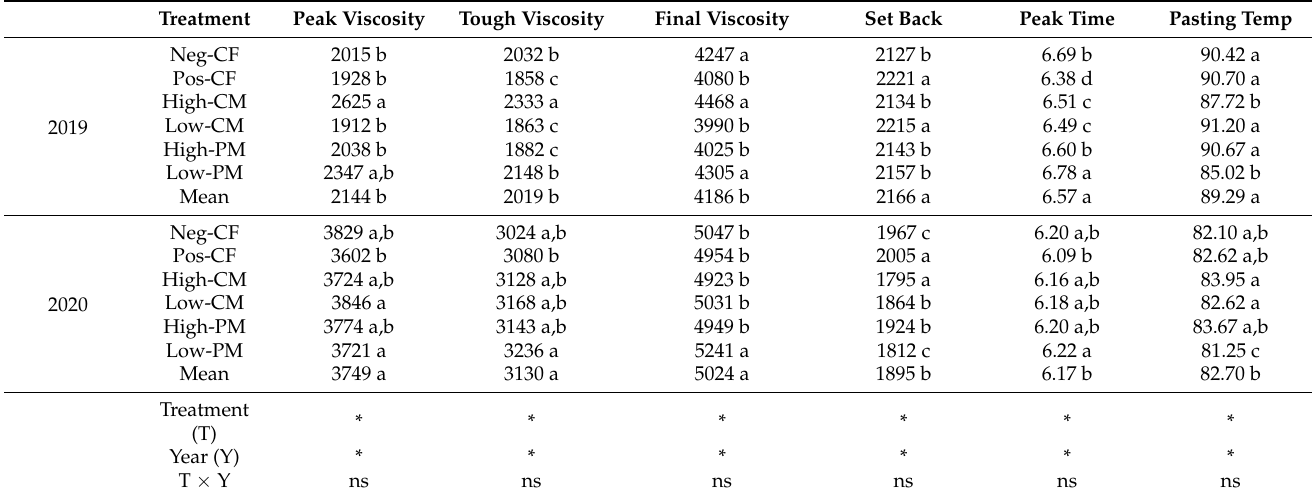
Table 4. Changes in the grain starch viscosity (RVA profile) characteristics under the combined organic and inorganic fertilization.